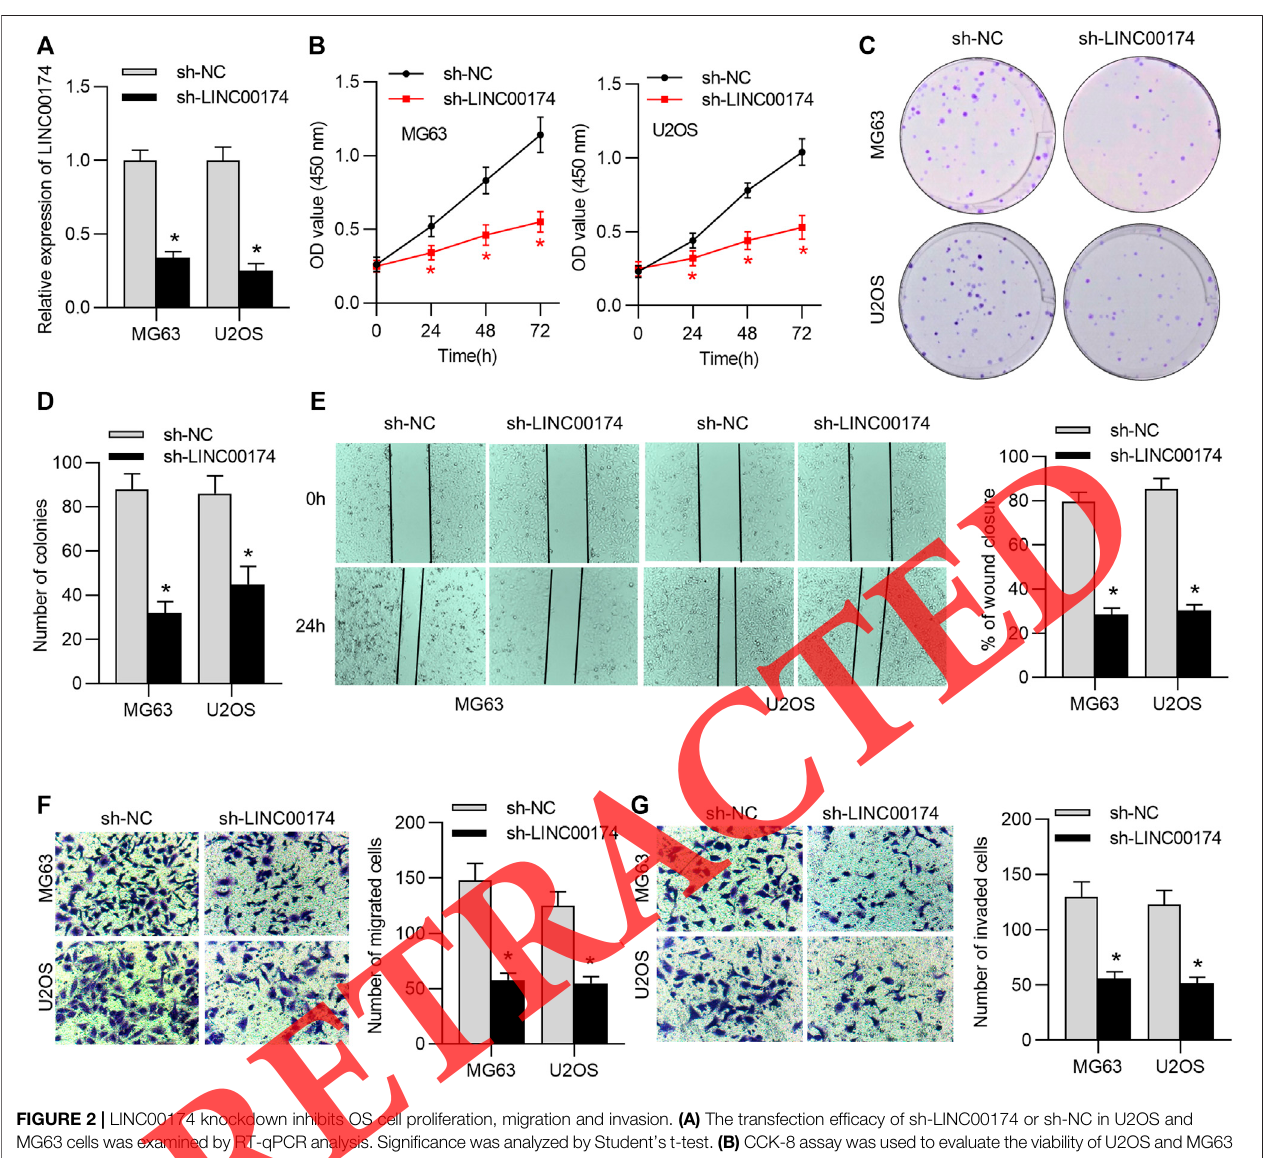
FIGURE 2 | LINC00174 knockdown inhibits OS cell proliferation, migration and invasion. (A) The transfection ef fi cacy of sh-LINC00174 or sh-NC in U2OS and MG63 cells was examined by RT-qPCR analysis. Signi fi cance was analyzed by Student ’ s t-test. (B) CCK-8 assay was used to evaluate the viability of U2OS and MG63 cells transfected with sh-LINC00174 and sh-NC. Signi fi cance was analyzed by Student ’ s t-test. (C,D) Colony formation assay was used to measure the proliferation of U2OSandMG63cellstransfectedwithsh-LINC00174andsh-NC.Signi fi cancewasanalyzedbyStudent ’ st-test. (E) Woundhealingassaywasusedtodetermine the migration of OS cells transfected with sh-LINC00174 and sh-NC. Signi fi cance was analyzed by Student ’ s t-test. (F,G) Transwell assays were used to detect the migration and invasion of OS cells transfected with sh-LINC00174 and sh-NC. Signi fi cance was analyzed by Student ’ s t-test. * p < 0.05.